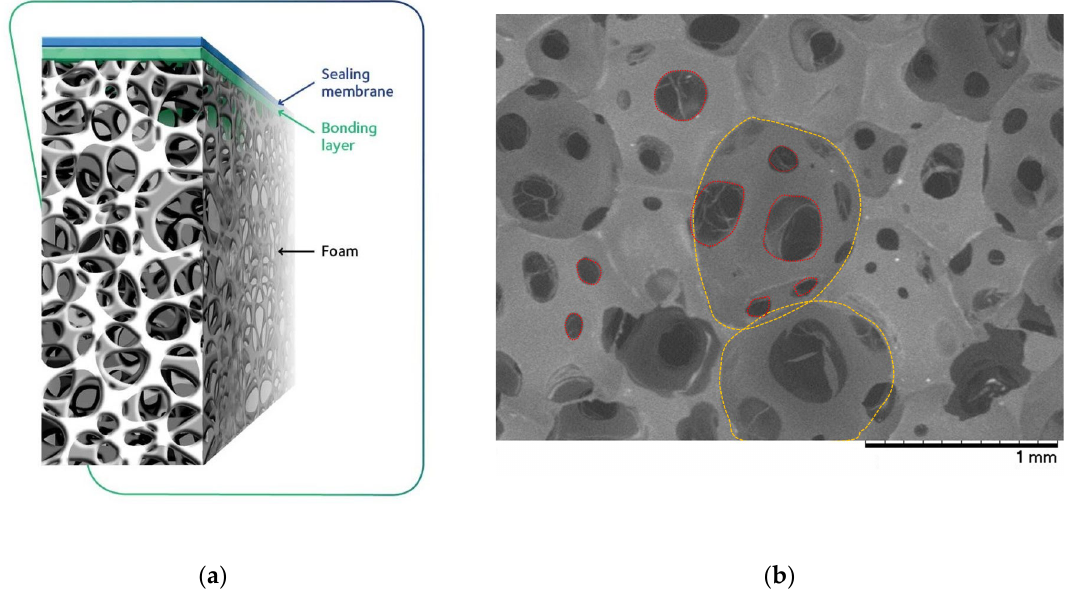
Figure 1. ( a ) Schematic of NovoSorb BTM showing the biodegradable polyurethane foam matrix bonded to the non-biodegradable polyurethane sealing membrane; ( b ) scanning electron microscope image showing microarchitecture of NovoSorb BTM. Chambers (yellow) are connected by pores (red) that vary in size, with an average of ~188 µ m. (© PolyNovo Biomaterials Pty Ltd., Used with